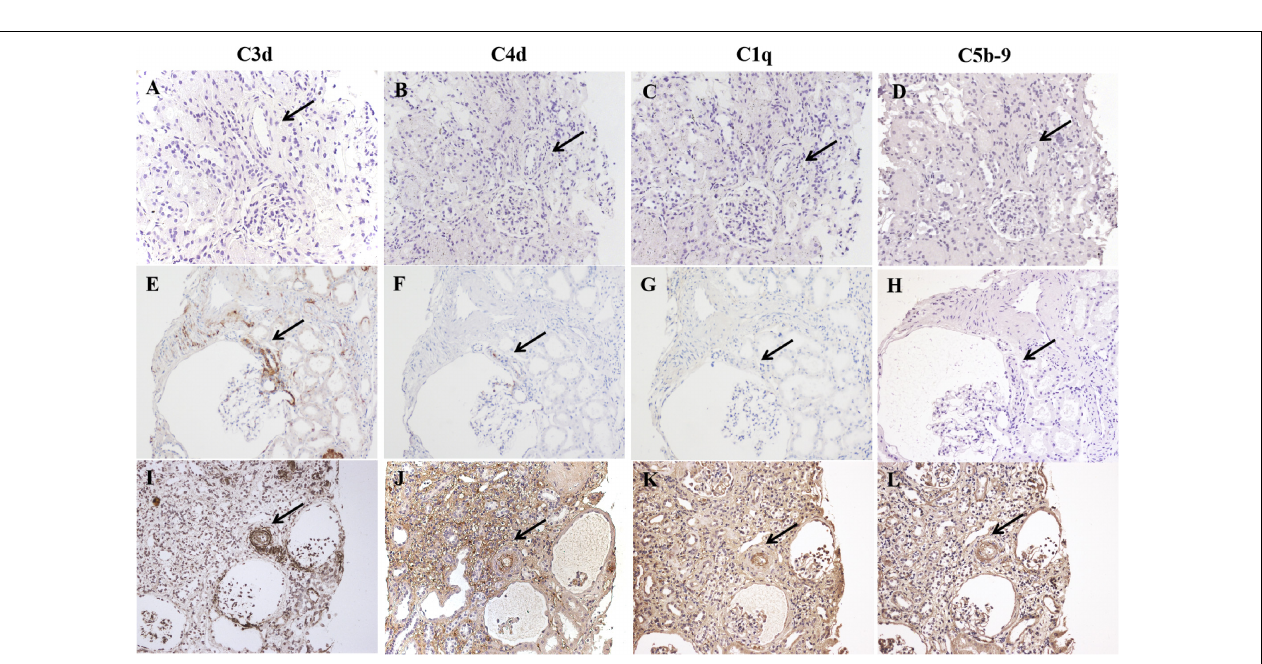
FIGURE 5 | Confocal images of C3d/CD34 (A–C) and C3d/ α -SMA (D–F) immunofluorescence staining in arterionephrosclerosis. (A,D) Showed C3d staining (green) on arterioles. (B) CD34 staining (red), which was deposited along the endothelial layer of arterioles and glomerular basement membrane. (E) For staining α -SMA (red) in arterioles. (C,F) Are merged images for C3d/CD34 and C3d/ α -SMA, respectively, showing C3d deposition mostly along the endothelial layer with some scattered in the interstitium (Magnification, 400 × ).